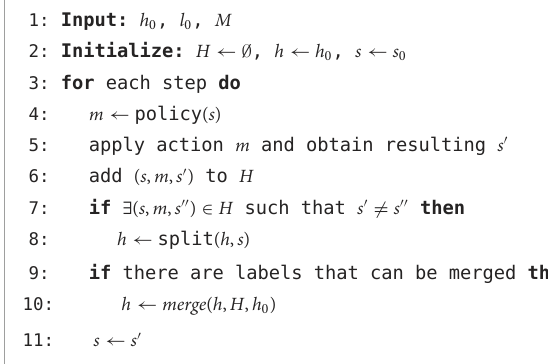
sufficient refinement computed by Algorithm 1 is minimal for the selected